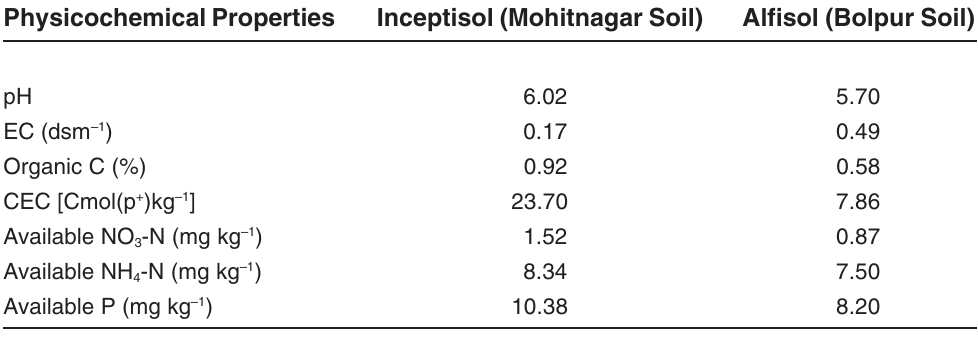
Physicochemical Properties of the Soil Used for the Experiment